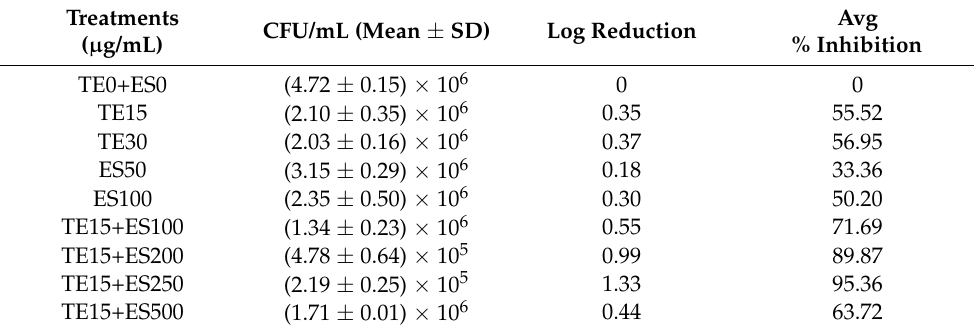
Table 5. Colony-forming units (CFU/mL) and respective log reduction and percentage of inhibition for different treatments on biofilm formation in S. epidermidis . TE: tetracycline; ES: EGCG-S.